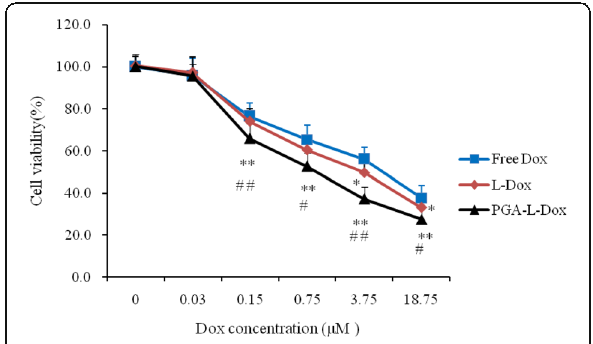
Fig. 2 Cytotoxicity of doxorubicin formulations on HepG2 cells after 48 h incubation with different doxorubicin concentration ( n = 5). * p < 0.05, ** p < 0.01, vs. free Dox. # p < 0.05, ## p < 0.01, vs.